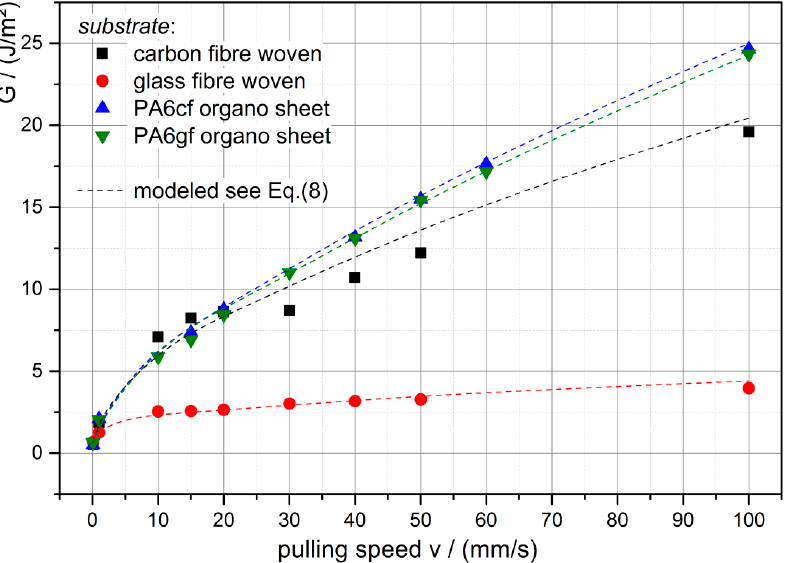
Figure 9. Critical energy release rate G versus the pulling speed v including the model of Equation (8) for each substrate.